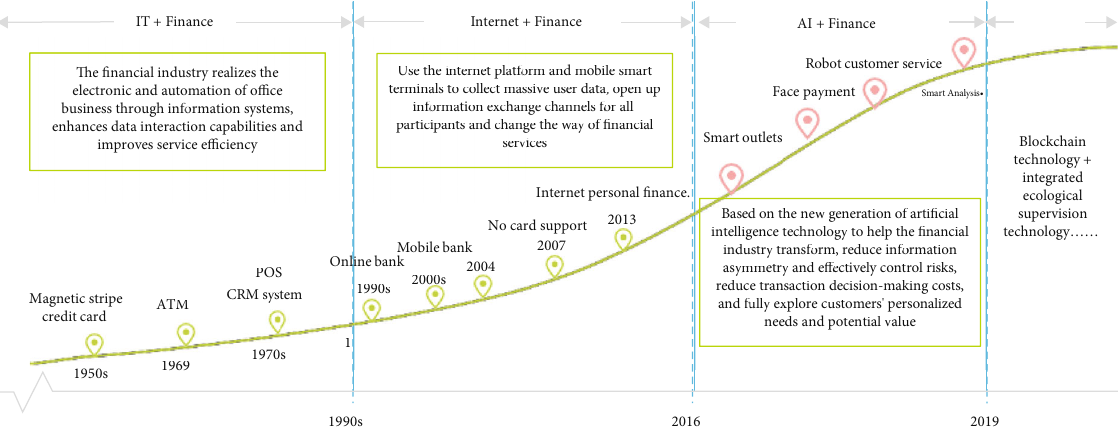
Figure 2: The development process of the technology-enabled fi nancial industry.